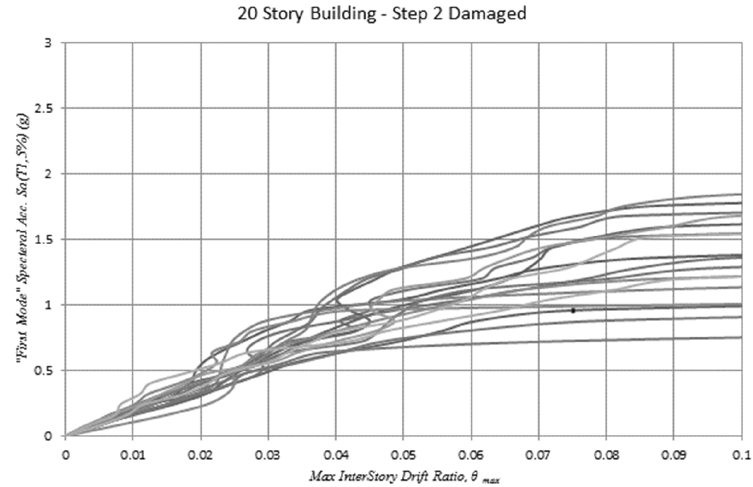
Figure 30. IDA curves obtained for a slightly damaged 20-story frame (by removing one beam and one column on the tenth floor in addition to removing one beam and one column on the fifth floor).